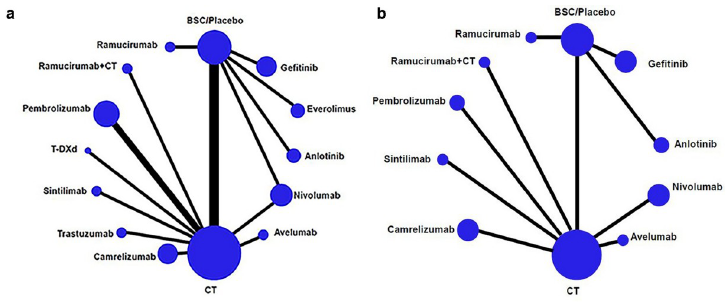
Fig 2. Network of eligible comparisons for the network meta-analysis. a, overall survival; b, progression-free survival. T-DXd, trastuzumab deruxtecan; CT, chemotherapy; BSC, best supportive care.